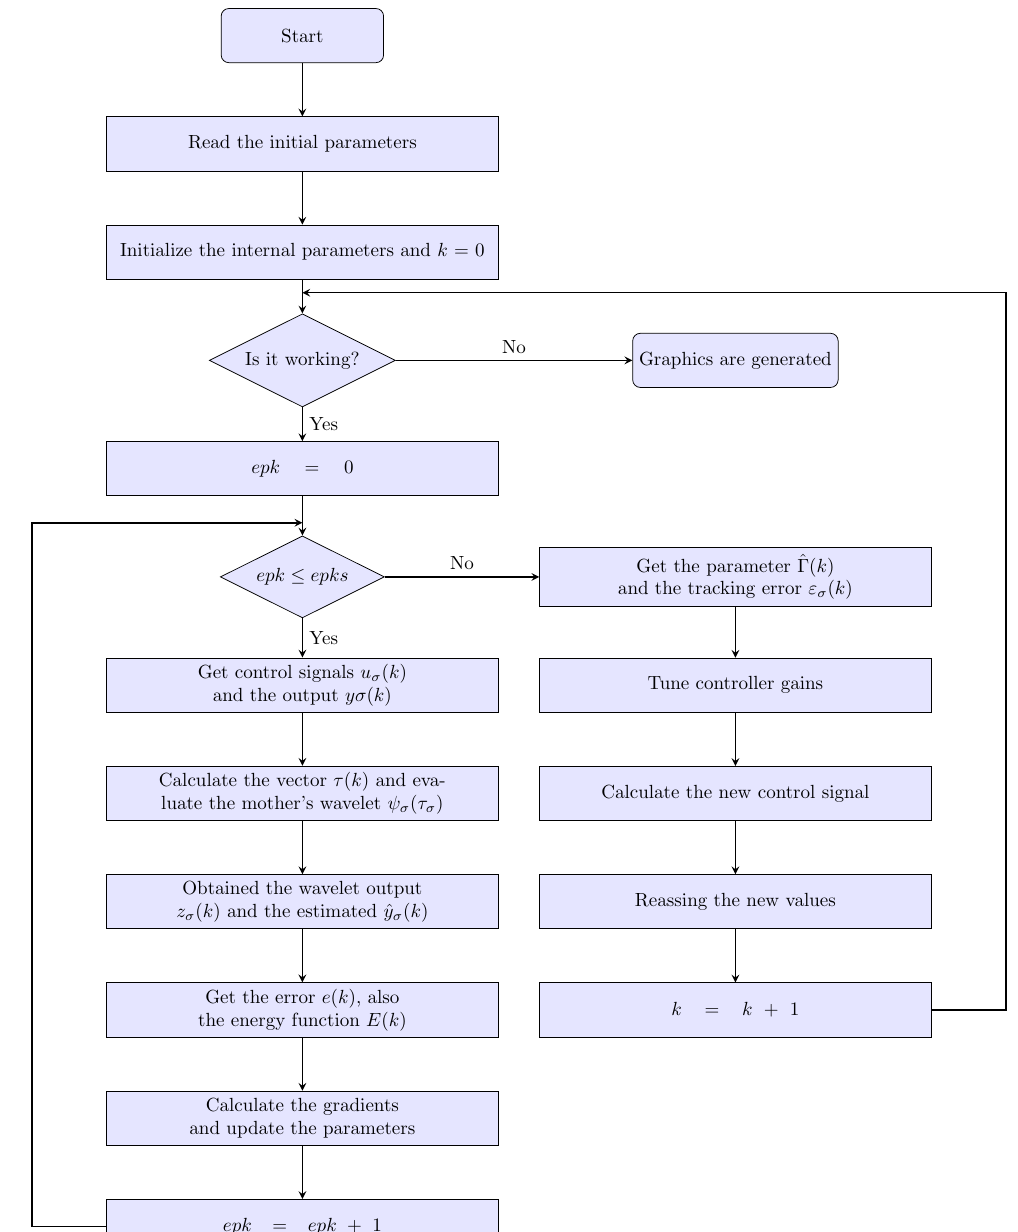
Figure 6. Flowchart of the PID wavenet algorithm